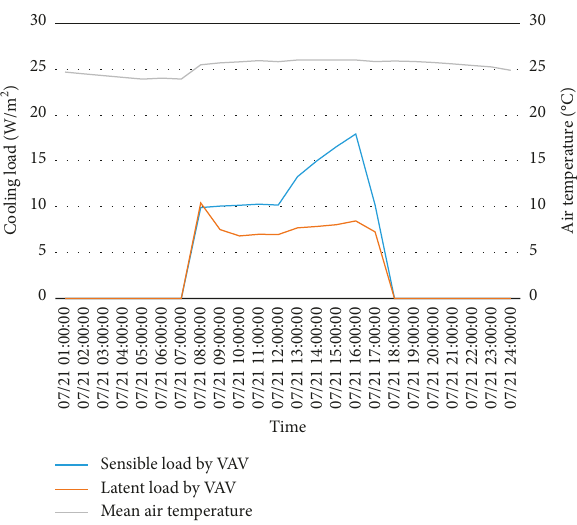
Figure 10: Sensible and latent load removed by VAV.